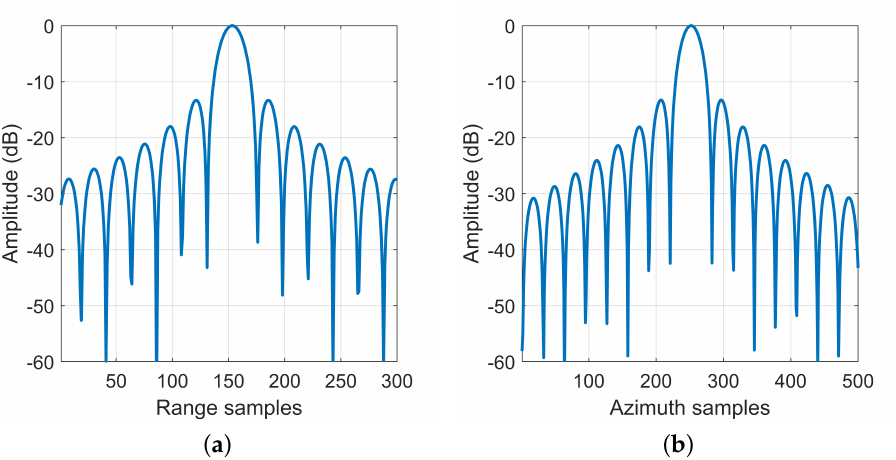
Figure 9. The profile of P 5 by using the non-start-stop model. ( a ) Range profile; ( b ) Azimuth profile.